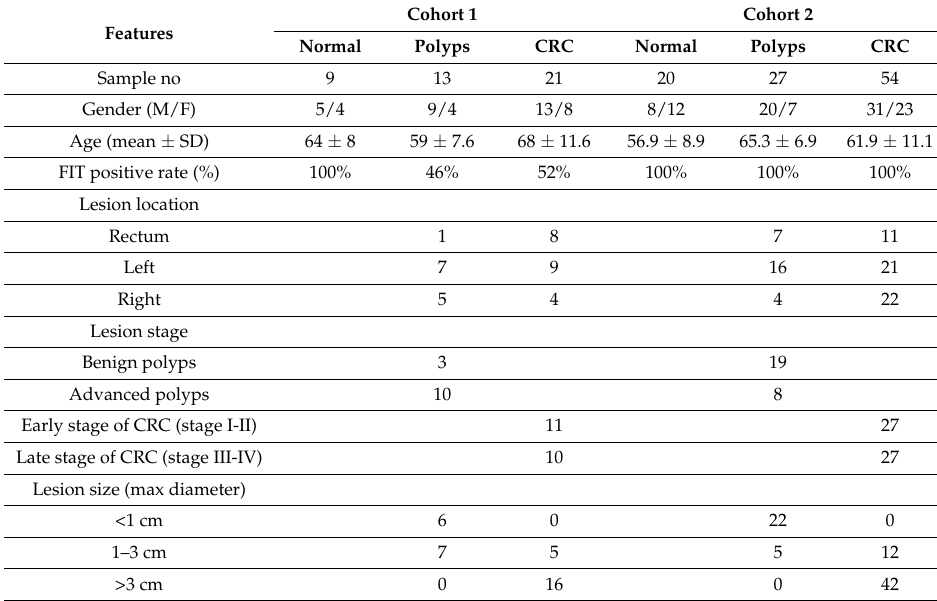
Table 2. Clinical characteristics of the two patient